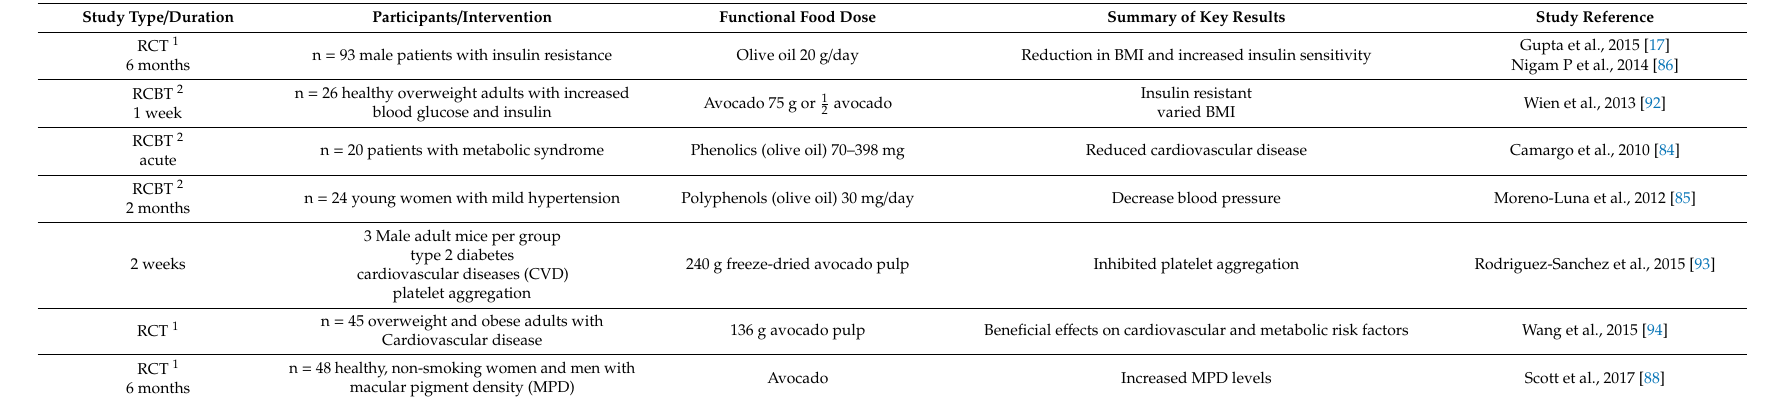
Table 6. Human intervention clinical studies about the possible e ff ects of olive oil and avocado on weight control, obesity, and its metabolic